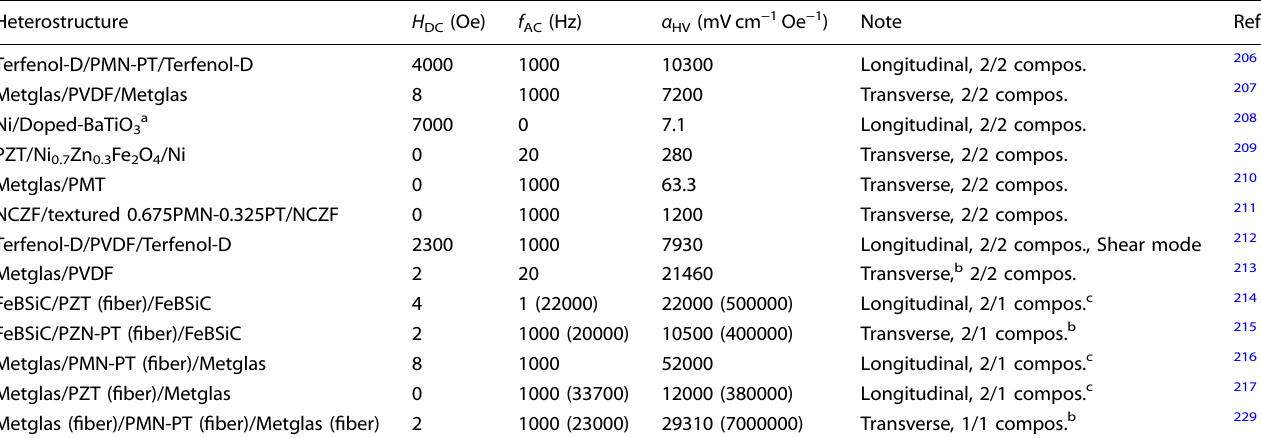
a A commercial multilayer capacitors consisting of Ni electrodes and BaTiO polarization in BaTiO 3 through VSM b Enhanced magnetic fl ux concentration inside the Metglas (FeBSiC) ribbon can enhance the magnitude of α c The ' 2 - 1' type phase connectivity leads to a signi fi cantly enhanced α